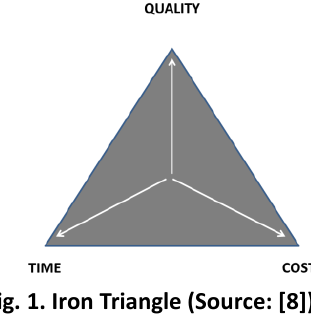
Fig. 1. Iron Triangle (Source: